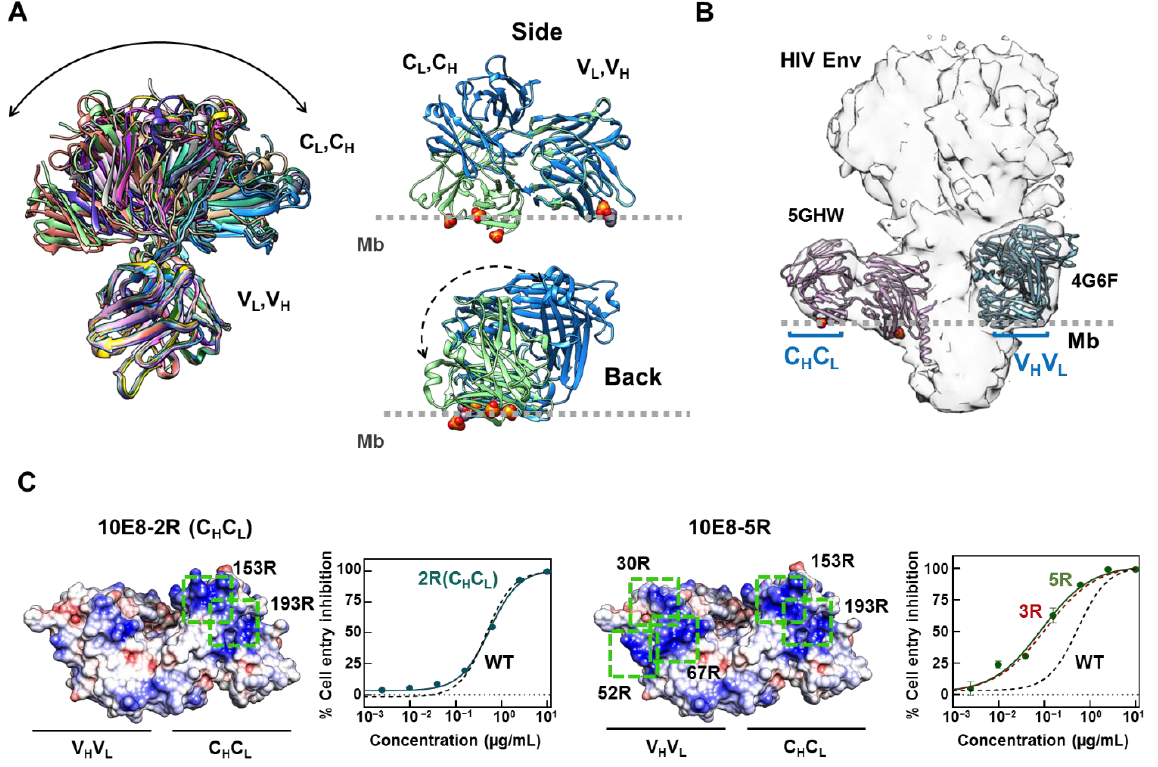
Figure 1. Delineation of membrane-facing/solvent-exposed surfaces in the Fab 10E8. ( A ) Left: superposition of a set of 10E8 Fab atomic structures with different elbow angles between the variable and constant domains. Superposed structures with PDB IDs 4G6F, 4U6G, 5GHW, 5IQ7, 5JNY, 5SY8, 5T29, 5T5B, 5T6L, 5T80, 5T85 and 5TFW are depicted. The V H V L domain was used for structure alignment. Right: Position relative to the membrane of Fab 10E8 structures with PDB ID 5GHW (green) and 5T29 (blue). The structures have been aligned through the V H V L domain and oriented based on the bound phosphates (red spheres) present in the former structure. The back side of the antibody emphasizes the possibility of the C H C L domain rotation to make contact with the mem- brane (Mb). ( B ) Fitting into Cryo-EM map of a Fab – Env trimer complex determined in detergent micelles (EMD-3312). Two Fabs, exhibiting full occupancy and different orientations are clearly dis- cernable (based on Fab structures 5GHW and 4G6F, as indicated in the panel). Membrane-facing areas hosting the Arg substitutions in both the variable (V H V L ) and constant (C H C L ) regions are high- lighted. ( C ) Pseudovirus neutralization and surface density charge representation of Fab 10E8 (PDB ID: 5GHW) with residues 153S and 193S in the constant region mutated to Arg alone, labeled as 10E8-2R (C H C L ) (left panels), or in combination with mutations S30R, N52R and S67R of Fab-3R labeled as 10E8-5R (right panels). The positions of the Arg mutations are highlighted with green boxes. Neutralization curves for 10E8-WT and 10E8-3R are shown for comparison. Structures dis- played in the panels rendered with Chimera [38]. 2.2. Requirements for Arg-Mediated 10E8 Potentiation and Complementation with HC-Ser100 c Phe Mutation Next, we studied the traits (positions and combinations) of the Arg-s introduced at the variable domain of the 3R mutant, which are required to potentiate the antibody. We generated single and double Arg mutants, and their potency was compared in pseudo- virus (PsV) neutralization assays (Figures 2 and Figure S1 (Supplementary Materials)). Adding single Arg residues at LC positions S30R, N52R or S67R was not sufficient to im- prove the ability of the Fab to block viral entry (Figure S1A). Similarly, the double combi- nations S30R/S67R or N52R/S67R, involving the LC FR3 residue S67, did not result in any